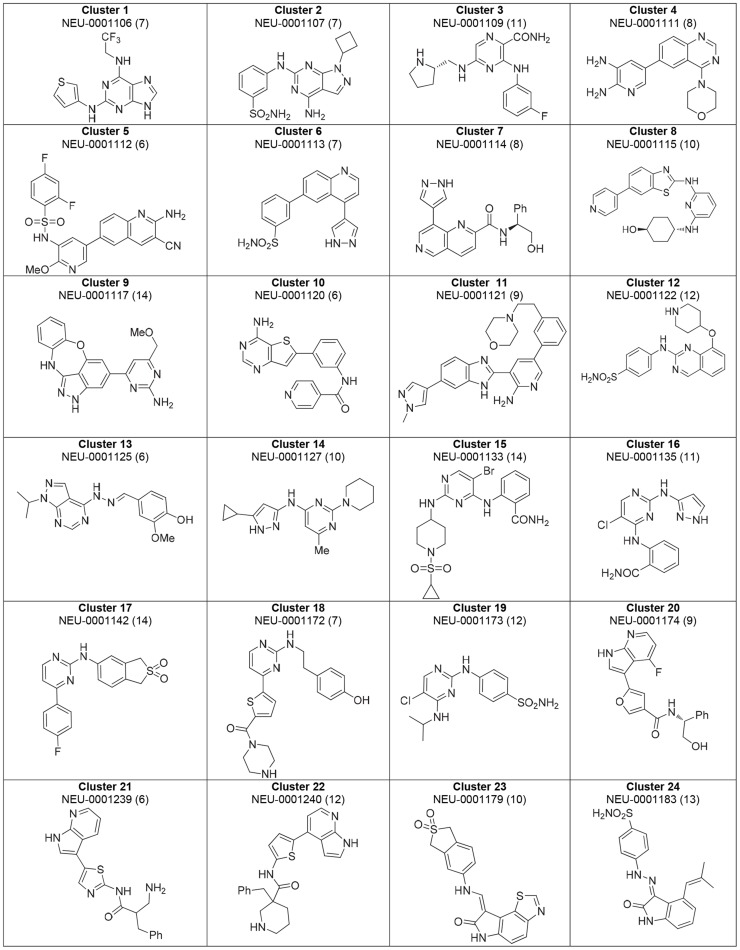
Highest-ranking cluster representatives for clusters 1-24.Each compound's composite score is shown in parentheses.